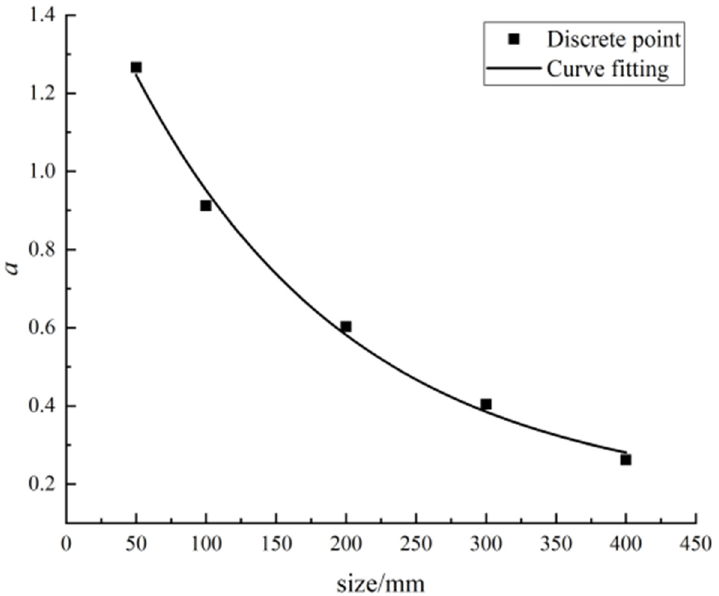
Figure 6. Fitting curve of parameter a and size.